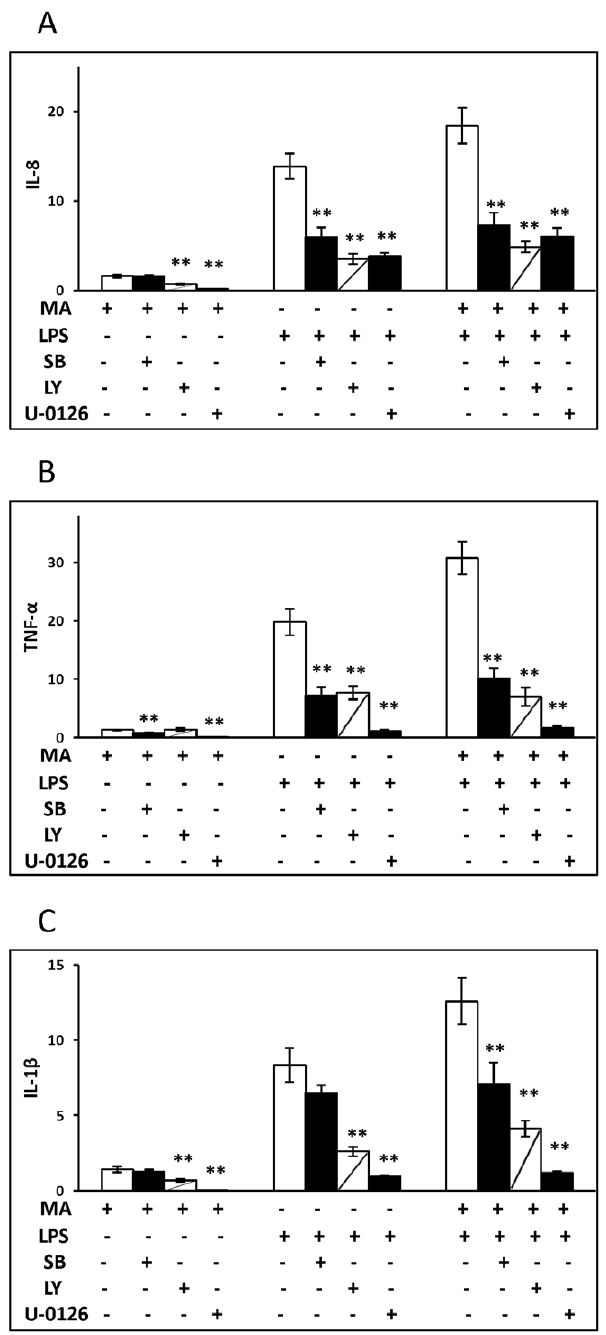
Figure 4. Inhibitors of MAPK or PI3-Akt abrogate cytokine/ chemokine expression induced by MA ± LPS. 1 6 10 6 U937 monocytes were differentiated into macrophages by treatment with 100 nM PMA for 48 h. p38 inhibitor SB203580, PI3K/Akt inhibitor LY294002 and ERK1/2 inhibitor U-0126 were added 1 h before MA exposure at 0, 24, 48 h. Cells were then challenged with LPS and the final dose of MA. After 3 h cells were harvested, RNA isolated and analyzed by real time RT-PCR. The means and SE values are from three independent experiments. *:p , 0.05; **: p , 0.01. Expression levels were compared to the identical treatment without